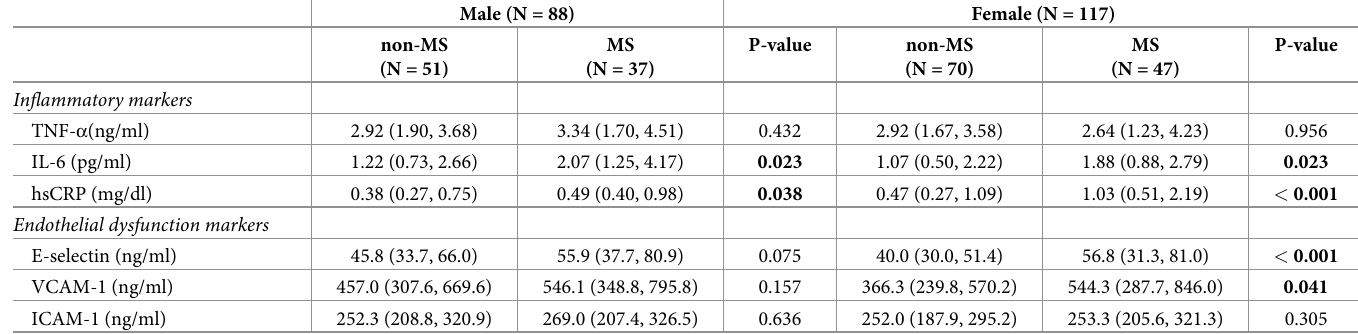
Table 2. Inflammatory markers (TNF- α , IL-6, hsCRP) and endothelial dysfunction markers (E-selectin, ICAM-1, VCAM-1) between MetS and non-MetS patients by